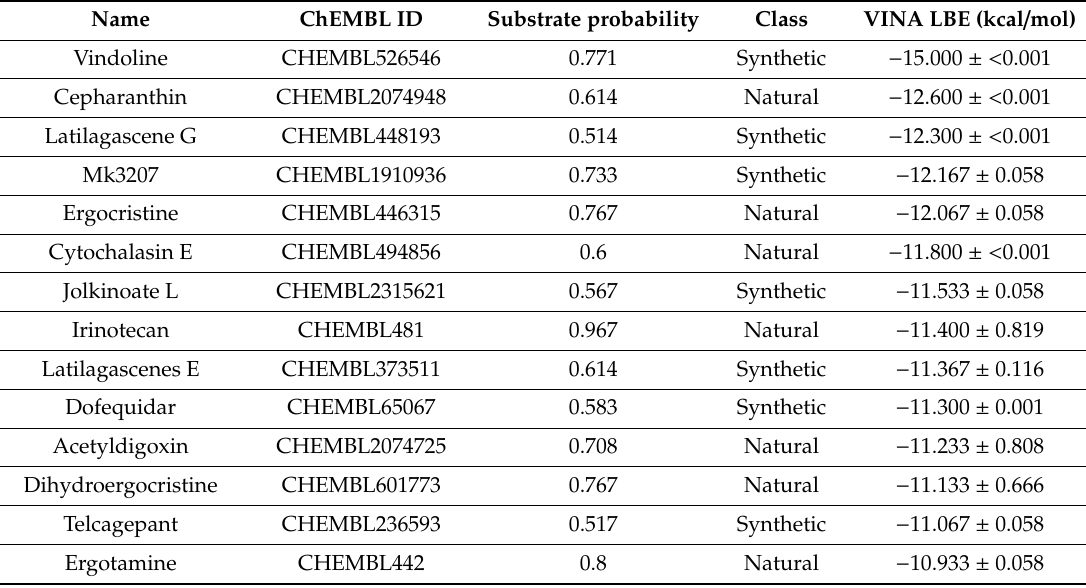
Table 7. Prediction of P-gp substrates identified by the RF classification algorithm using the ChEMBL P-gp modulator list of 150 compounds. The results were validated by determining the binding a ffi nities using Autodock